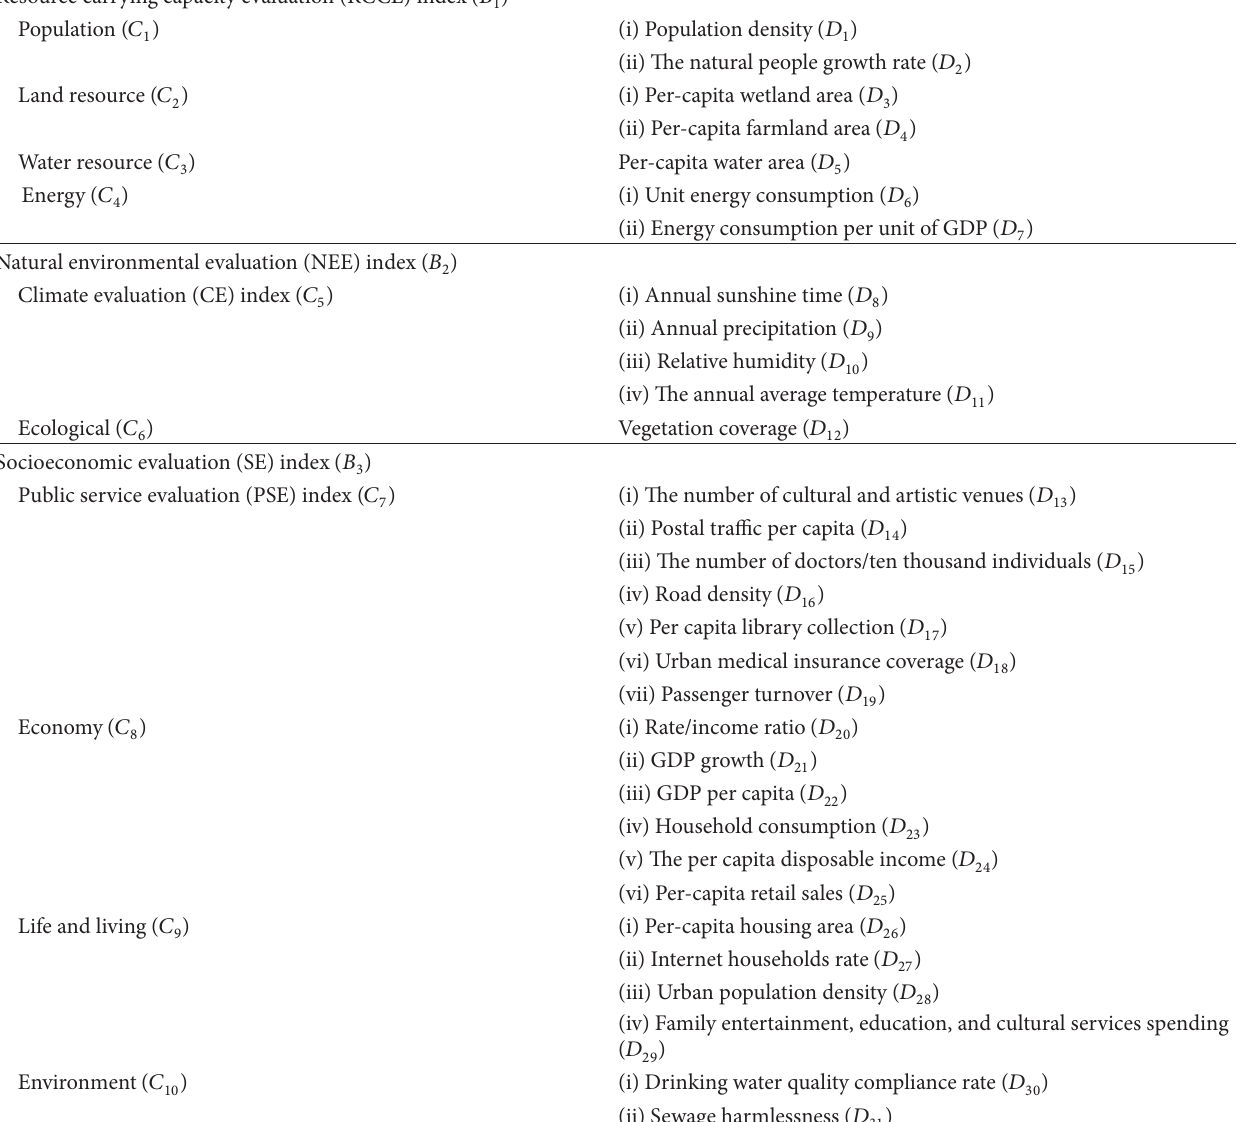
Table 1: The human living environmental evaluation (HLEE) index